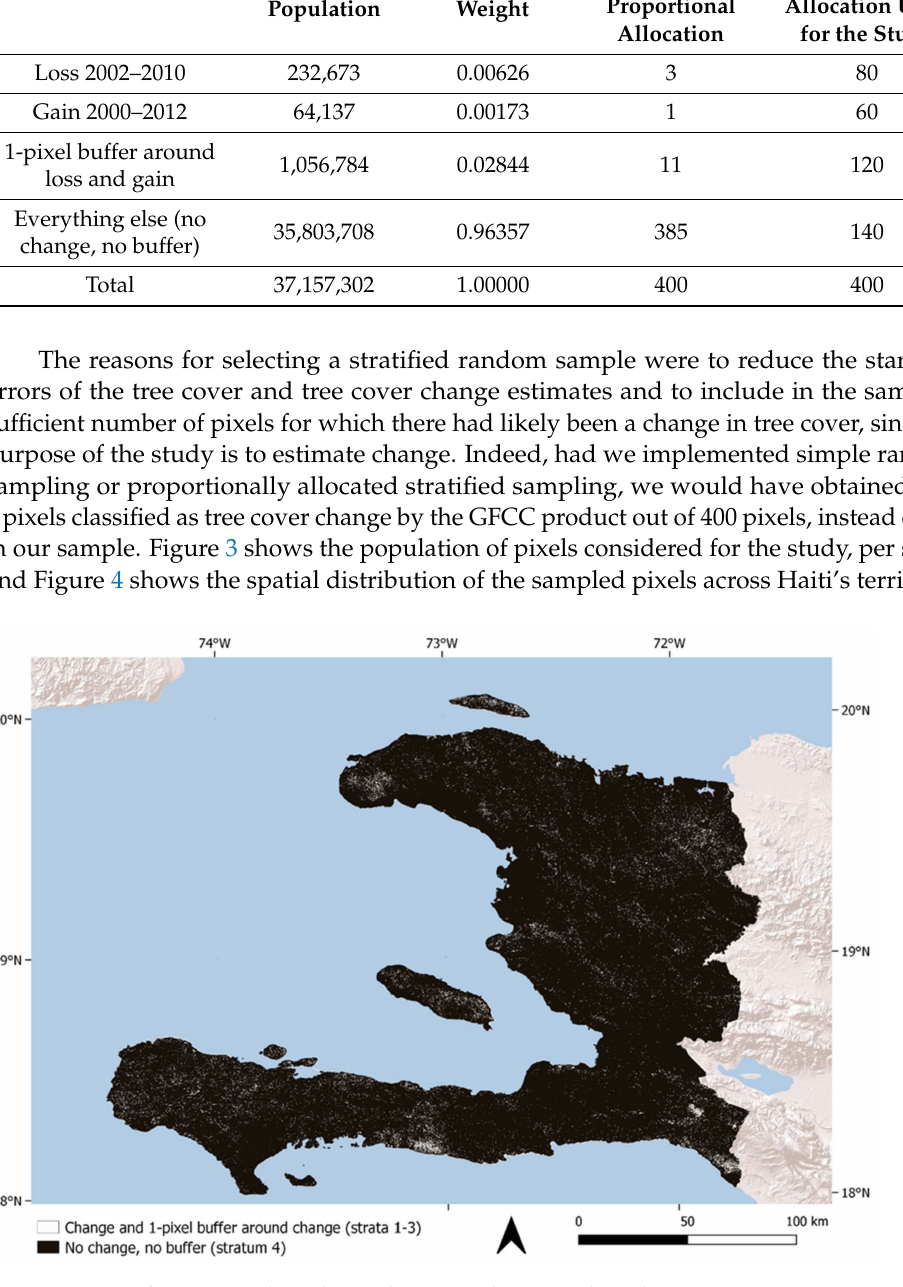
Figure 3. Map of GFCC pixels in the study’s area, change and no change